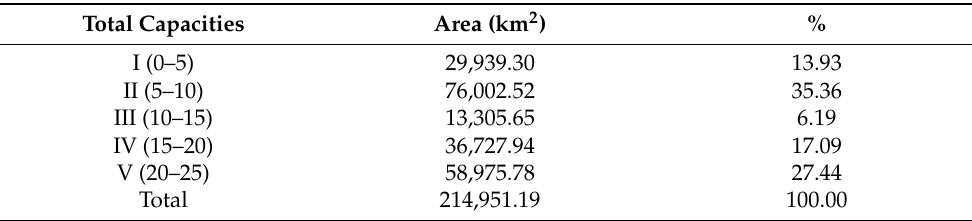
Table 4. Areas and proportions of different levels of provisioning services.